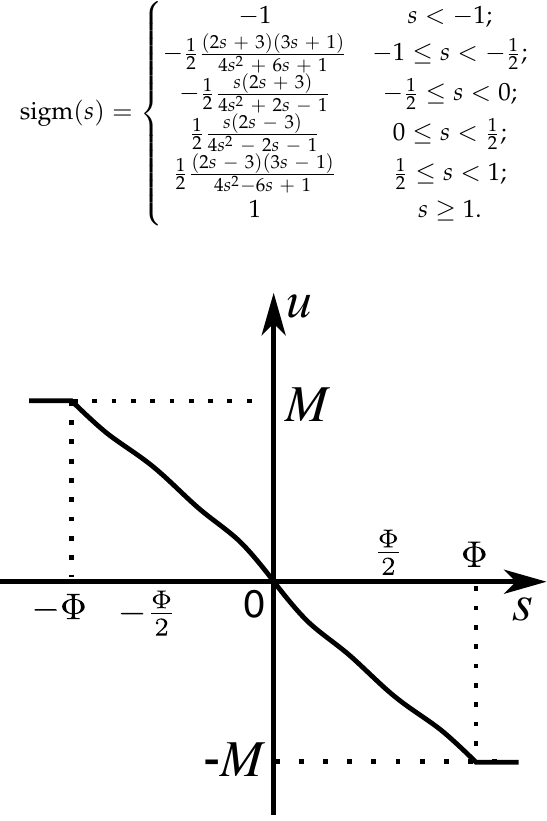
Figure 6. Output of the AHN controller with sliding